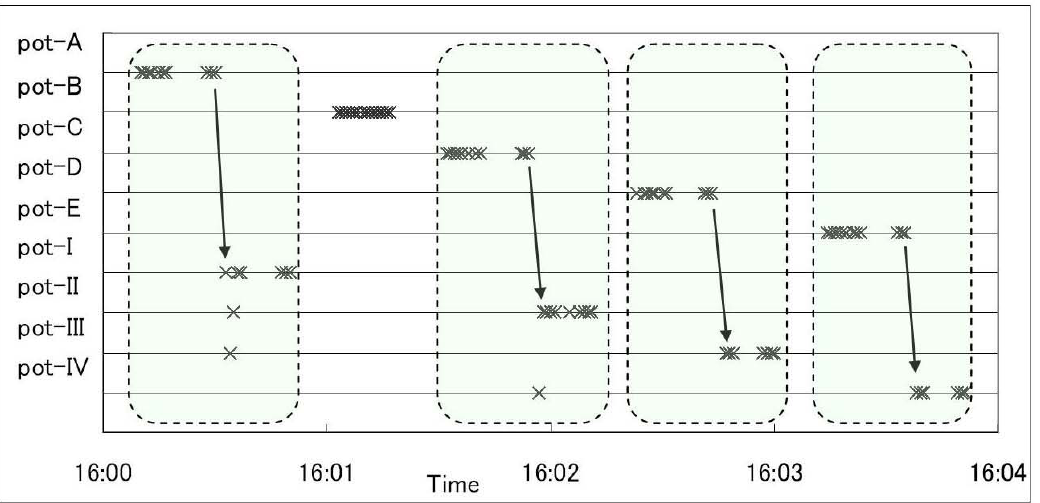
Figure 6. Recognition result of transplanting